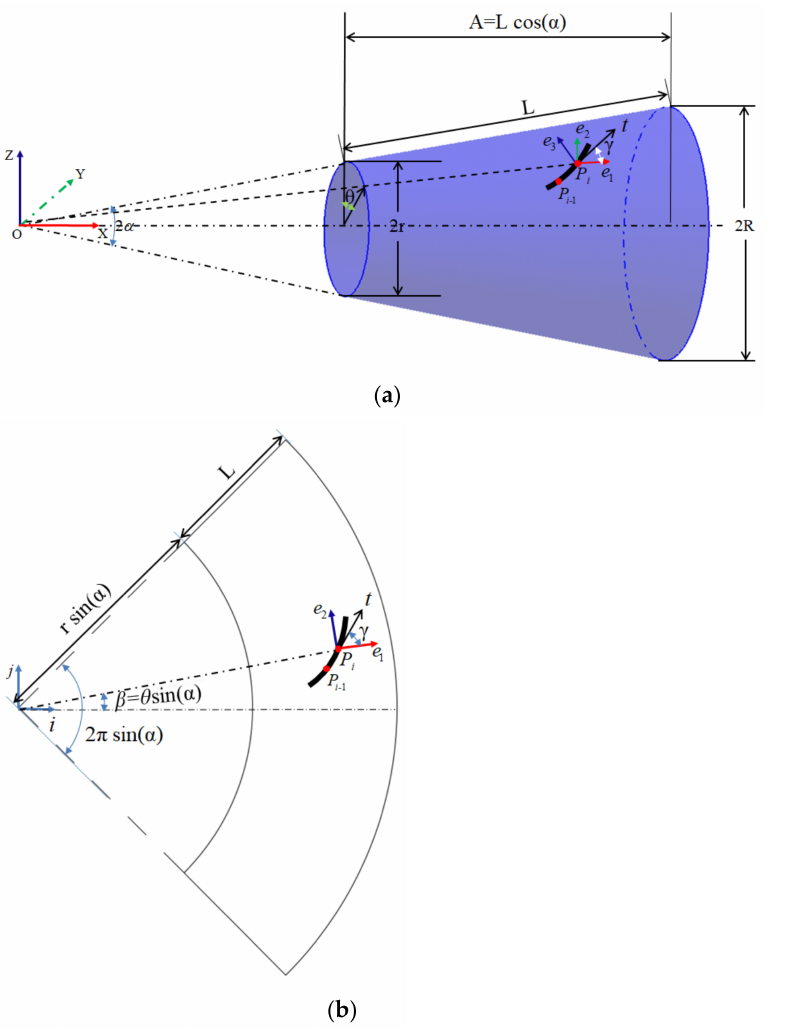
Figure 1. Cone geometry. ( a ) Three-dimensional schematic diagram of the conical shell. ( b ) Devel- oped surface of the conical shell.